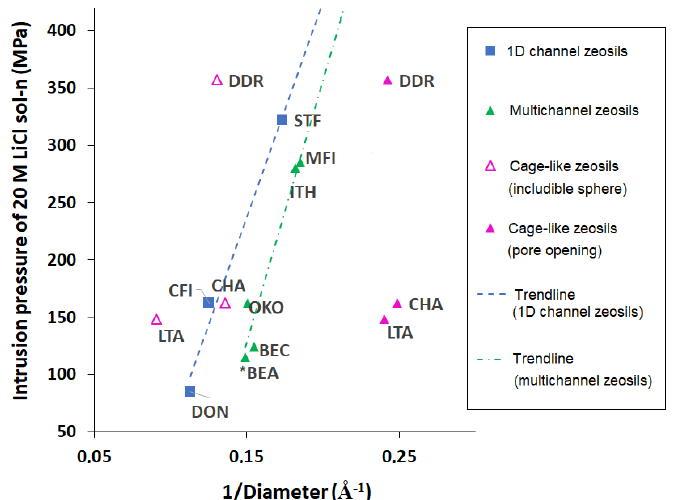
Figure 5. Intrusion pressure of 20 M LiCl aqueous solution versus the inverse of the average diameter of the pores: for 1D and multichannel zeolites as the average of the diameter opening; for cage like zeolites as the maximum diameter of the sphere that can be included in the pores (empty symbol), and as the average dimeter of the pore